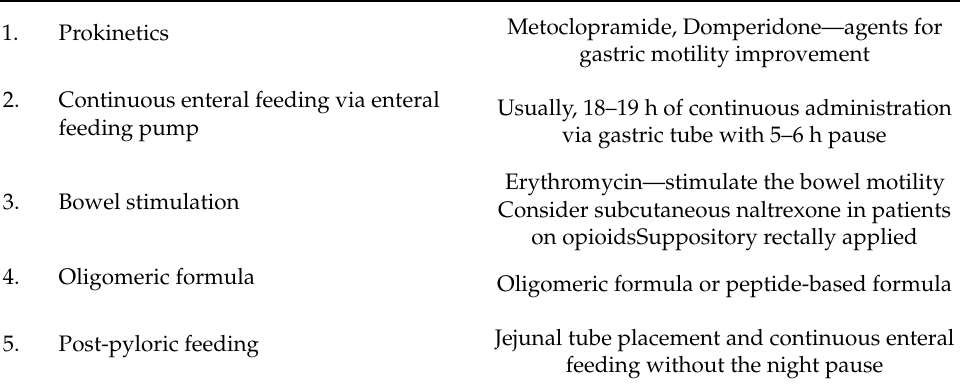
Table 5. Methods to improve enteral feeding